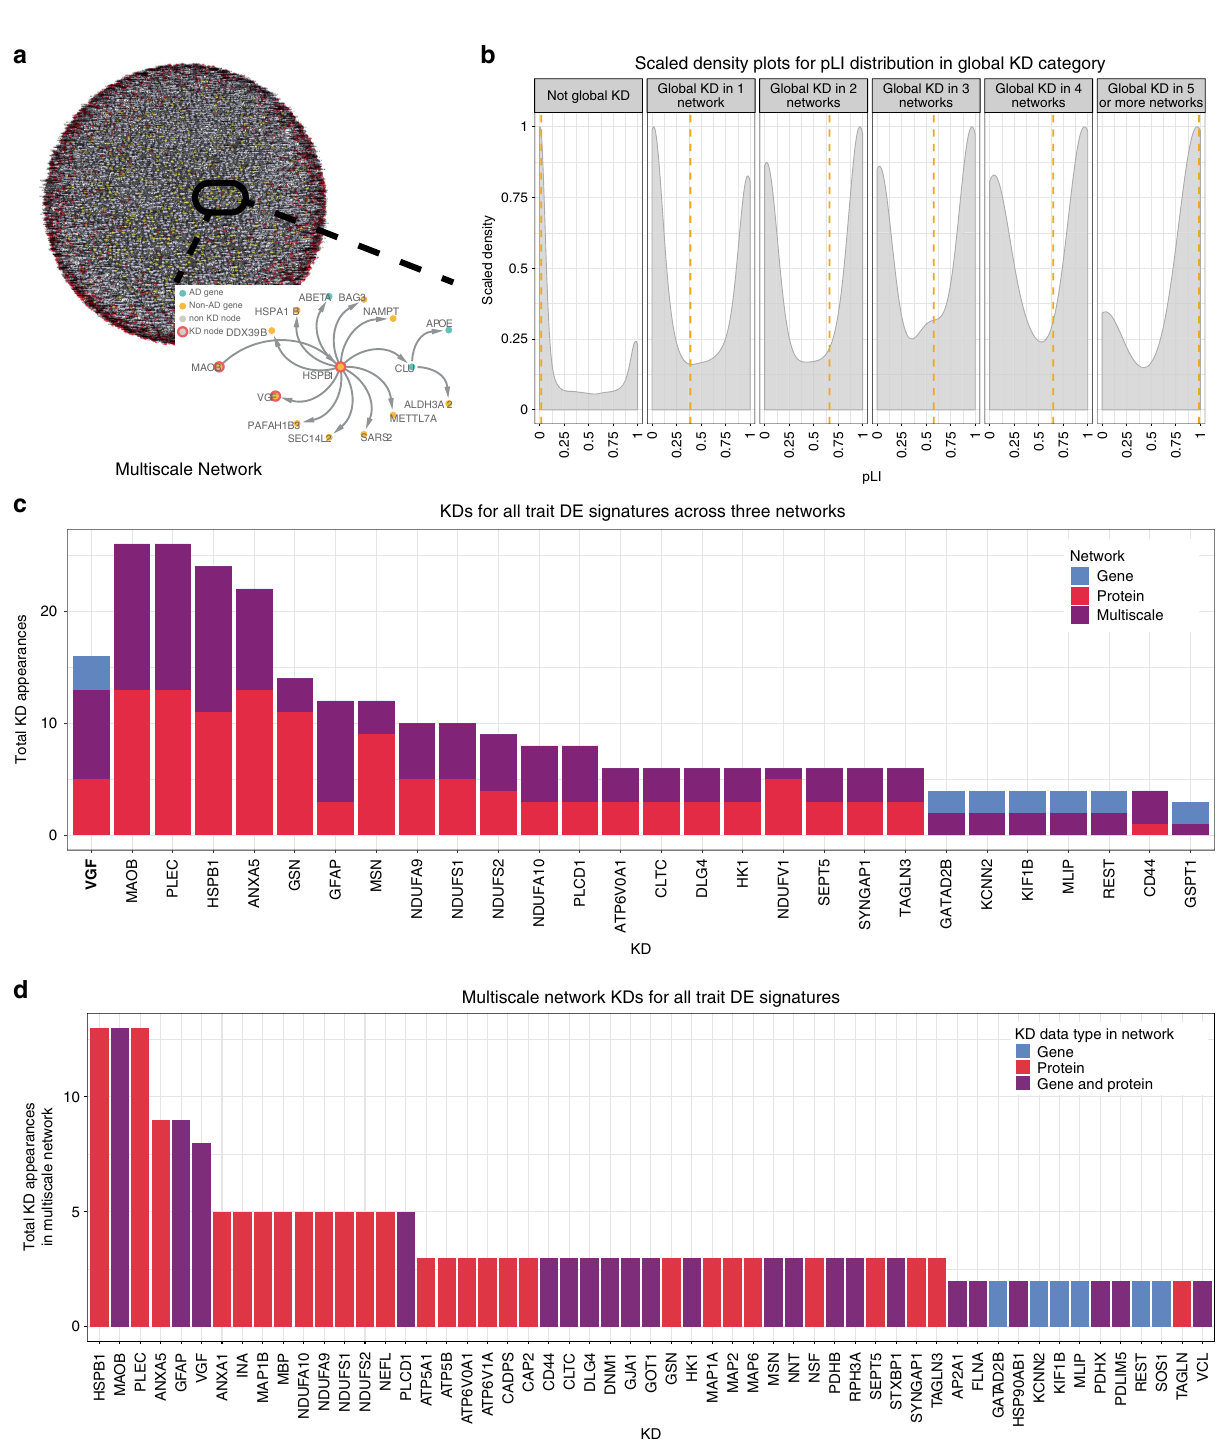
Fig. 4 Bayesian causal networks and key drivers. a Full Bayesian network and an APOE subnetwork. Background visualization of the multiscale AD network described in the main text using an edge-weighted spring embedded layout. The red nodes are proteins and the blue nodes genes. Key driver (KD) genes and proteins are highlighted in yellow. Foreground multiscale subnetwork comprised of genes within a path length of 3 to APOE. Node names and properties are de fi ned in the panel legend. b Density plots of the distribution of pLI scores for genes and proteins by the number of times they appear as global KDs across the three discovery and four replication networks. The yellow dashed line represents the median pLI score for that category. c Distribution of the number of times genes and proteins across all three discovery networks were identi fi ed as KDs across all DE signatures. The x - and y - axis depict the different KDs appearing in at least two networks and the number of times they are identi fi ed as KDs for DE signatures across all three networks. The colors of the bars are indicative of the network of origin of the KDs. d KD of DE signatures in the multiscale network, as described for ( b ). The color of the bars is indicative of KDs presence only in the gene expression, protein expression, or in